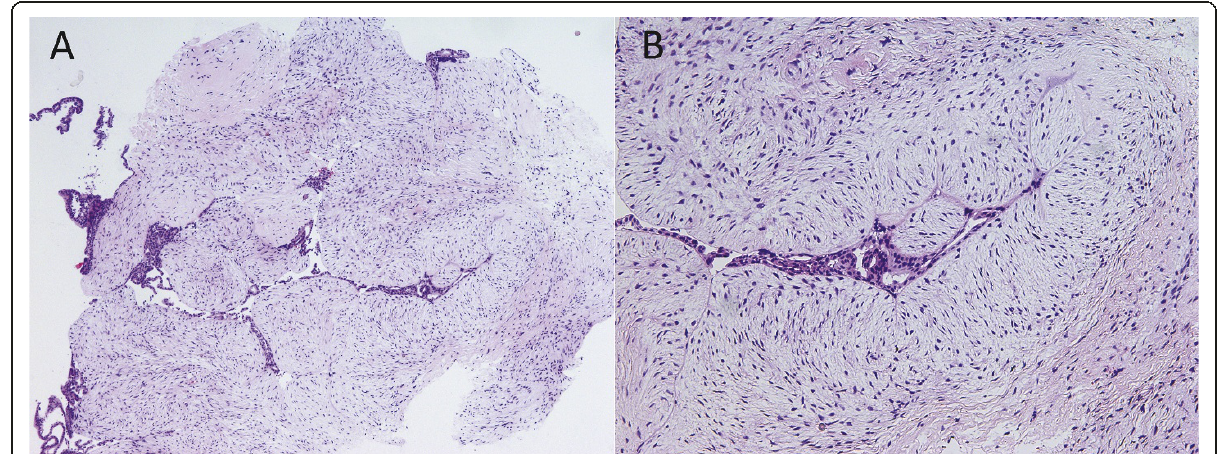
Figure 1 Core needle biopsy specimen of the breast showing fibroadenoma . (HE), 40 × (A), 100 ×